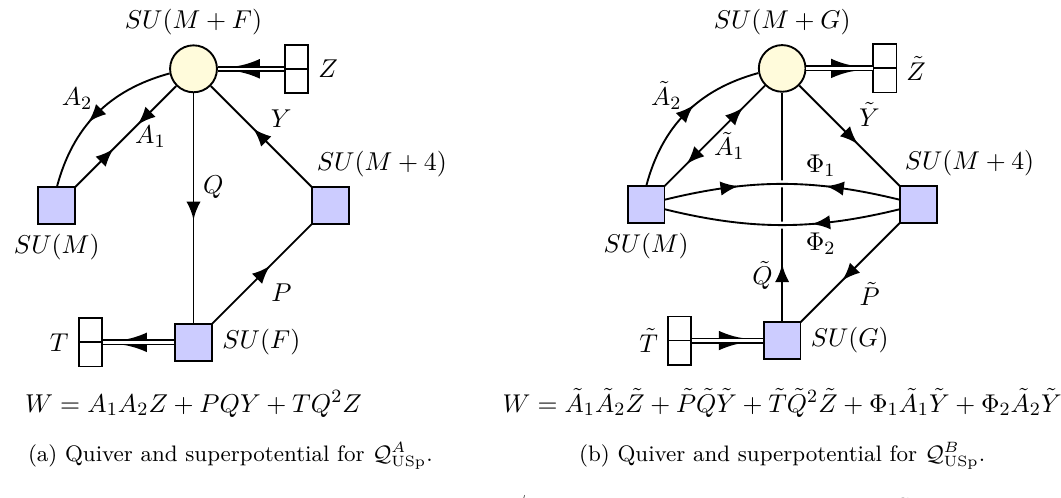
Figure 9. Two Lagrangian descriptions of q φ reproduced from [19] with modifications.]